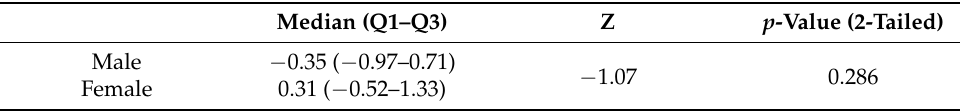
Table 6. Result of Mann–Whitney U